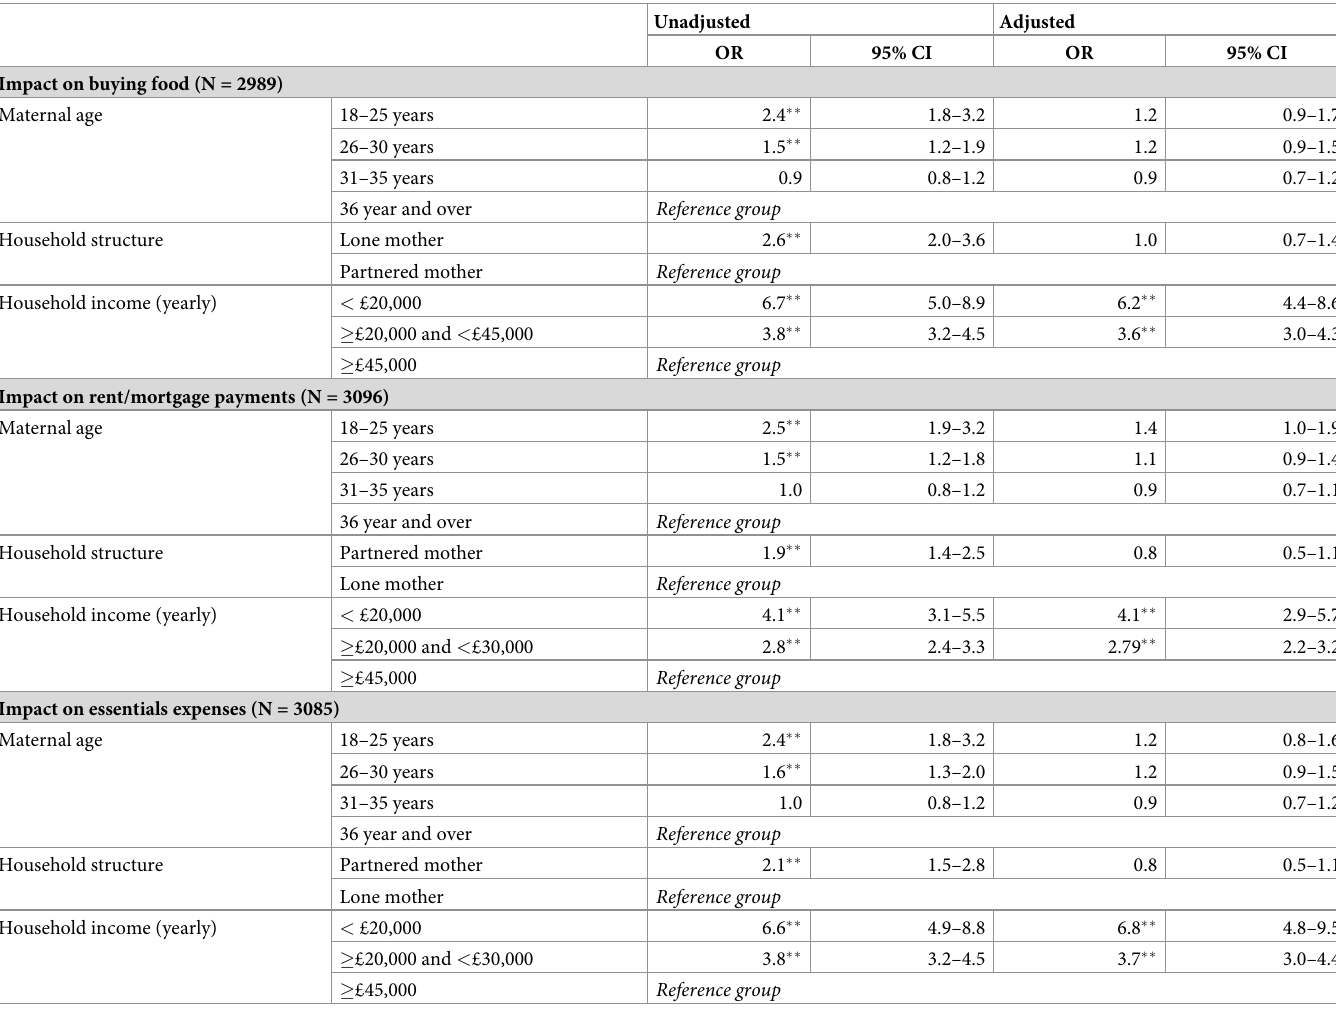
Table 3. Multiple regression of the COVID-19 pandemic impact on ability to pay for expenses by maternal age, household structure and income in the UK COVID- 19 New Mum Study (28 th May 2020-26 th June 2021).